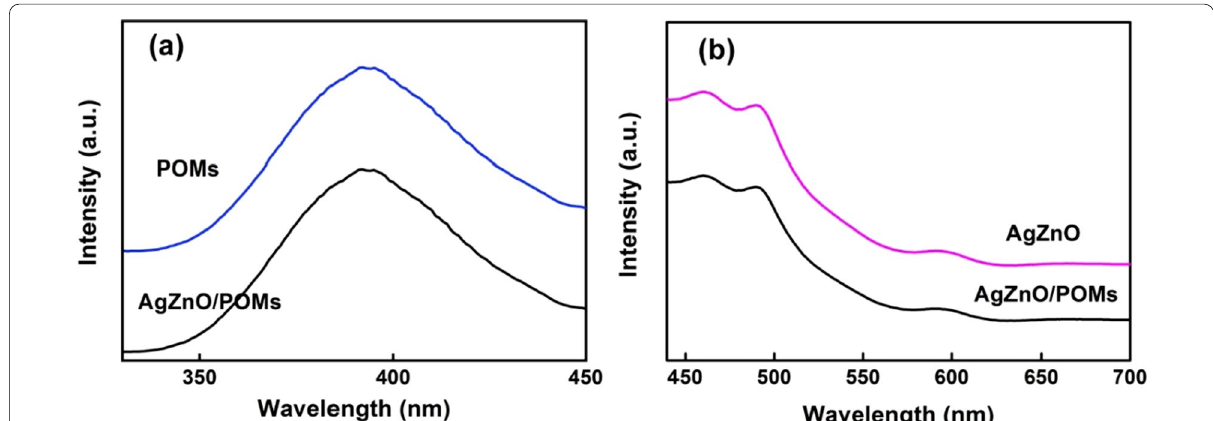
Fig. 6 a Solid PL emission spectra of POMs and AgZnO/POMs with excitation wavelength λ ex AgZnO/POMs with excitation wavelength λ ex